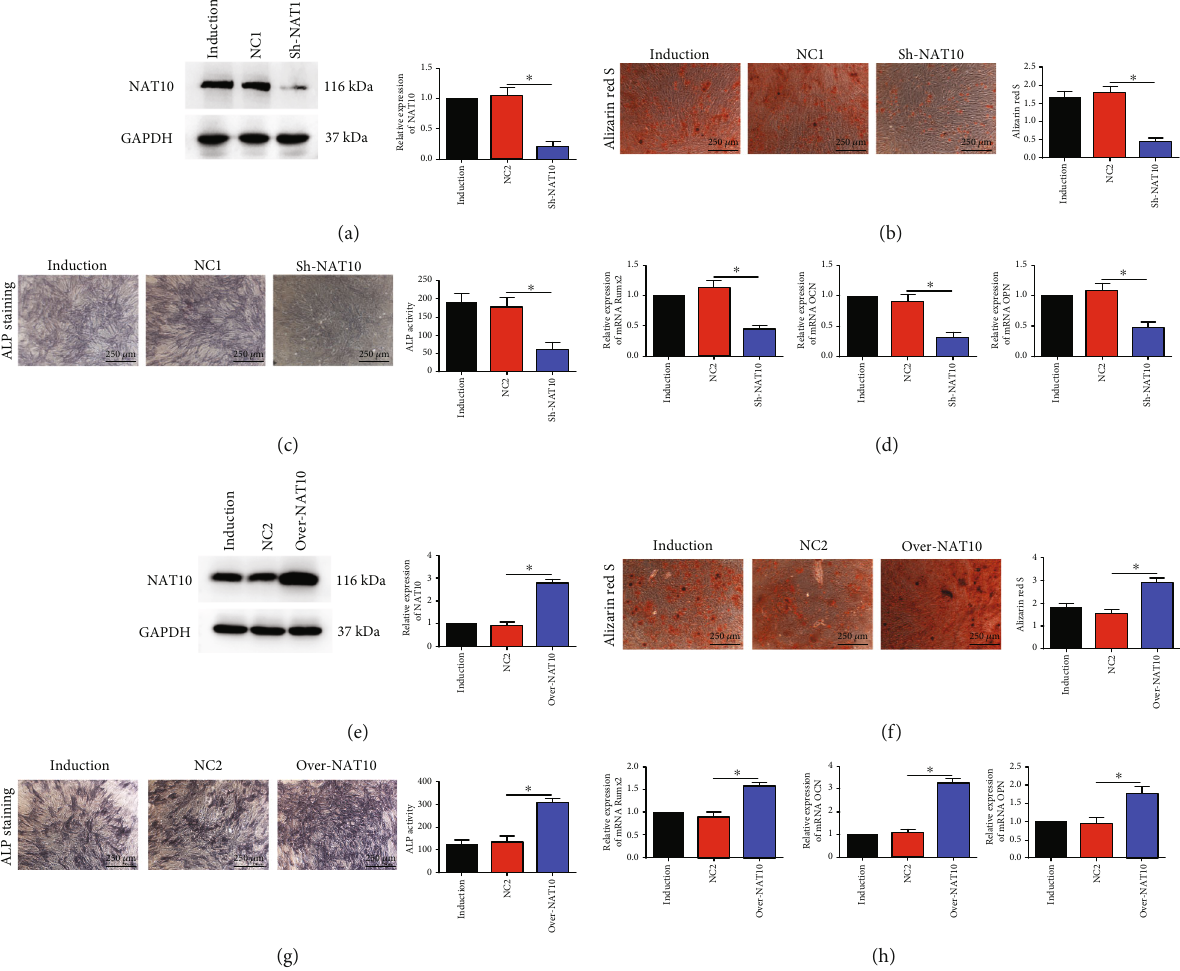
Figure 2: NAT10 positively regulated the osteogenic capacity of MSCs. (a) Sh-NAT10 signi fi cantly decreased the protein level of NAT10. (b) ARS staining and quanti fi cation were decreased in the Sh-NAT10 group compared to the negative control (NC) lentivirus group. Scale bar = 250 μ m . (c) ALP staining and activity were decreased in the Sh-NAT10 group compared to the NC lentivirus group. Scale bar = 250 μ m . (d) RUNX2, OPN, and OCN mRNA expression was decreased in the Sh-NAT10 group. (e) Over-NAT10 signi fi cantly increased the protein level of NAT10. (f) ARS staining and quanti fi cation were increased in the Over-NAT10 group compared to the NC lentivirus group. Scale bar = 250 μ m . (g) ALP staining and activity were increased in the Over-NAT10 group compared to the NC lentivirus group. Scale bar = 250 μ m . (h) RUNX2, OPN, and OCN mRNA expression was increased in the Over-NAT10 group. ∗ indicates P < 0 : 05 . All experiments were repeated three times. The induction group indicates MSCs undergoing osteogenic di ff erentiation without other treatment. NC1 indicates control lentivirus-transfected MSCs undergoing osteogenic di ff